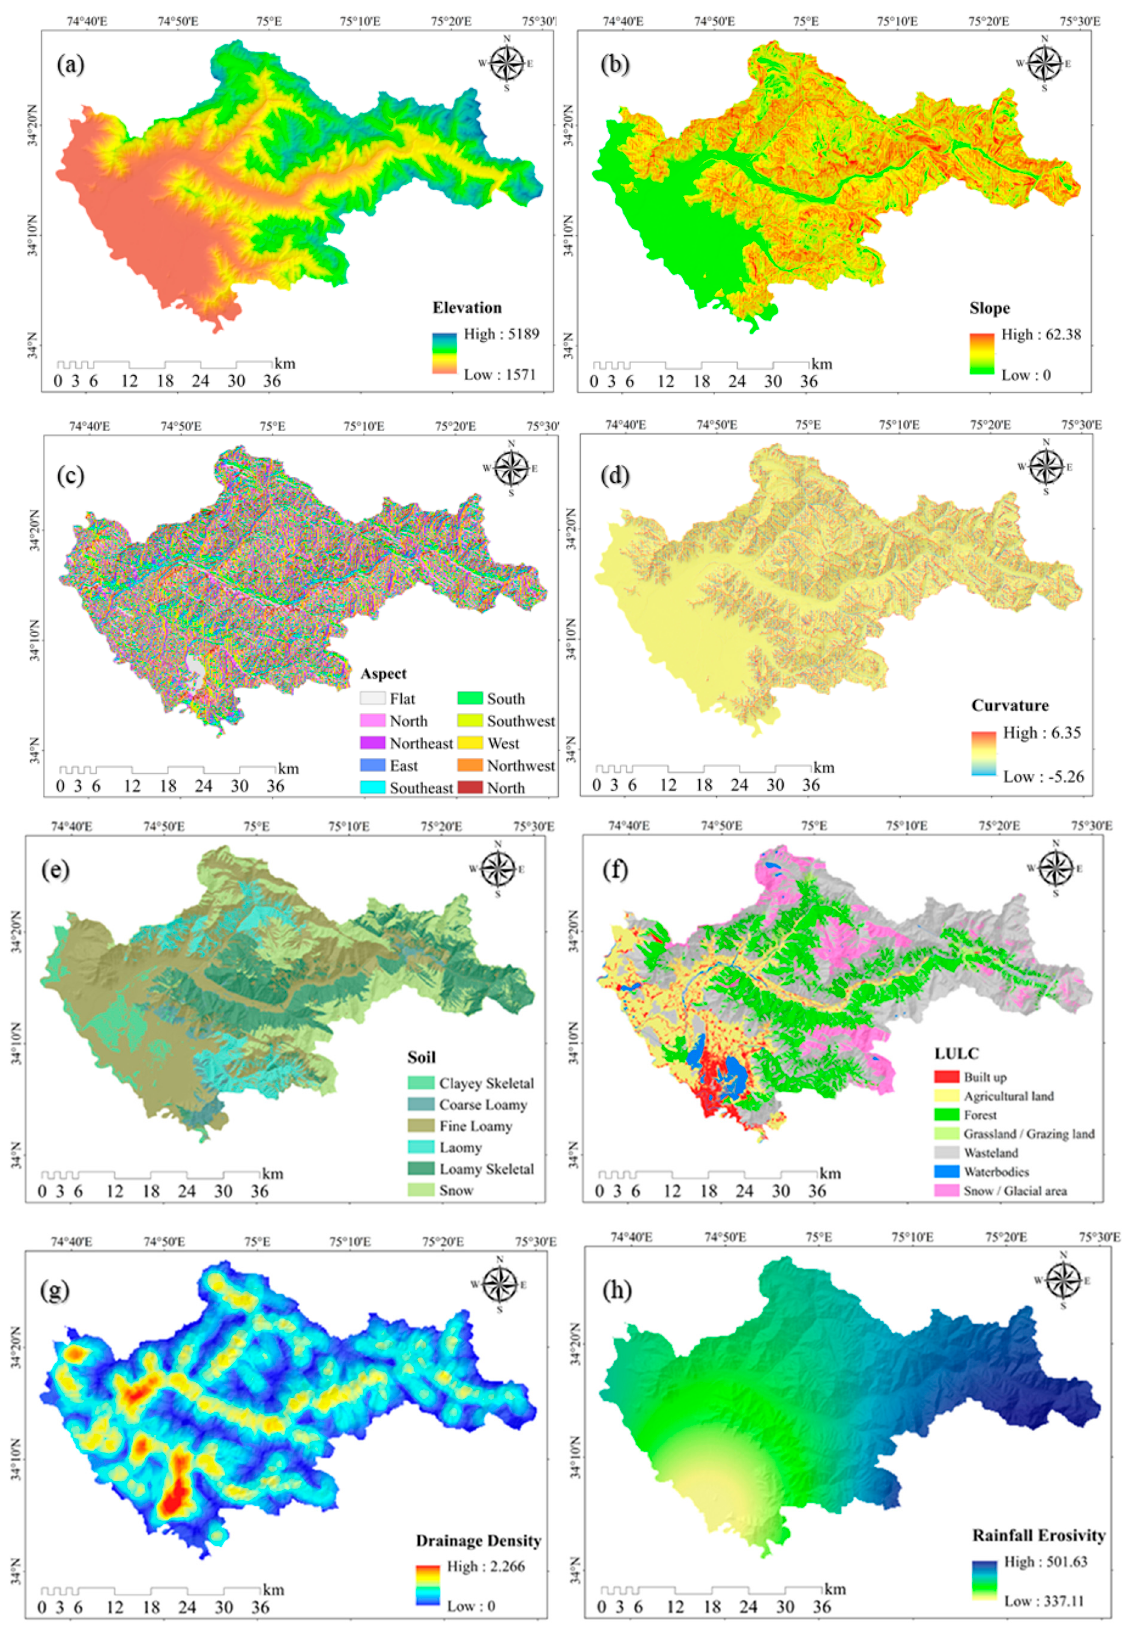
Figure 3. Parameters considered for the estimation of soil erosion severity. ( a ) Elevation, ( b ) Slope, ( c ) Aspect, ( d ) Curvature, ( e ) Soil, ( f ) LULC, ( g ) Drainage Density, ( h ) Rainfall Erosivity.